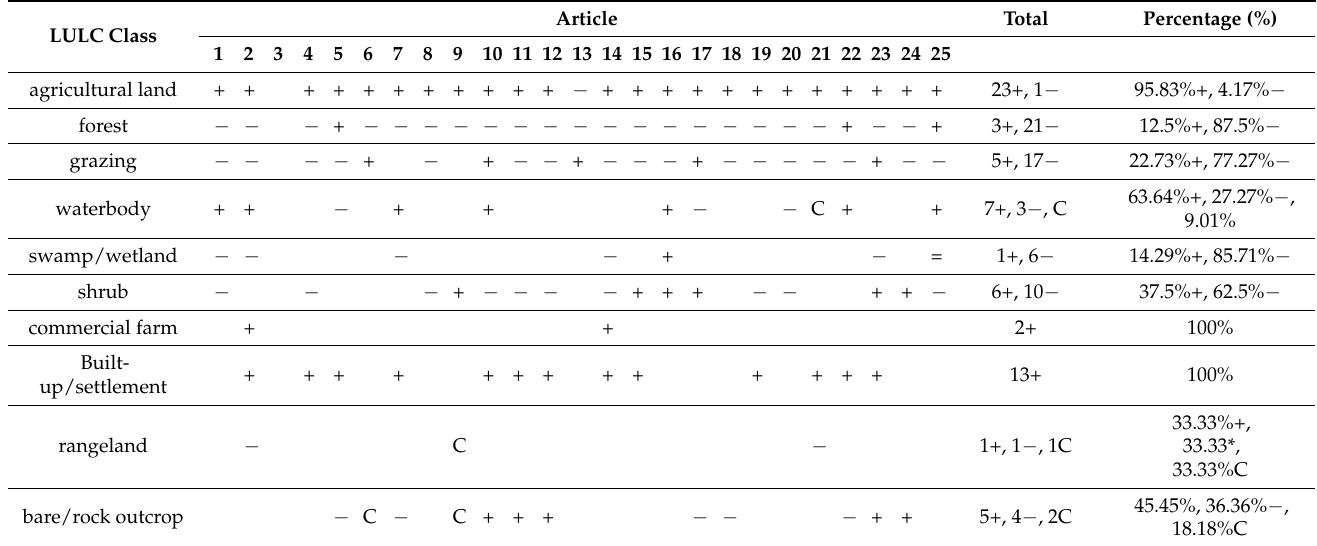
Table 3. Land use land cover change considered in the reviewed